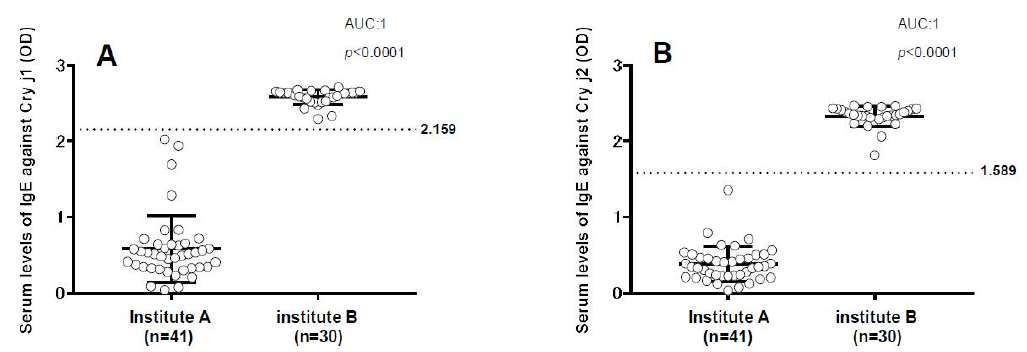
Figure 2. Evaluation of seroprevalence of immunoglobulin E (IgE) antibodies against Japanese cedar pollen allergens Cry j1 and Cry j2 in dogs ( A ) Dot plot showing the distribution of IgE against Cry j1 in dog serum obtained from institutes A (n = 41) and B (n = 30) by enzyme linked immunosorbent assay (ELISA). ( B ) Dot plot showing the distribution of IgE against Cry j2 in dog serum obtained from institutes A and B by ELISA. The dotted line indicates the cut-off value, while bars indicate the mean ± standard deviation.